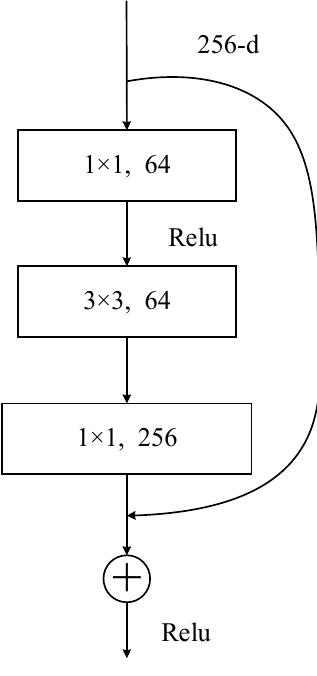
Figure 9. Residual network structure.